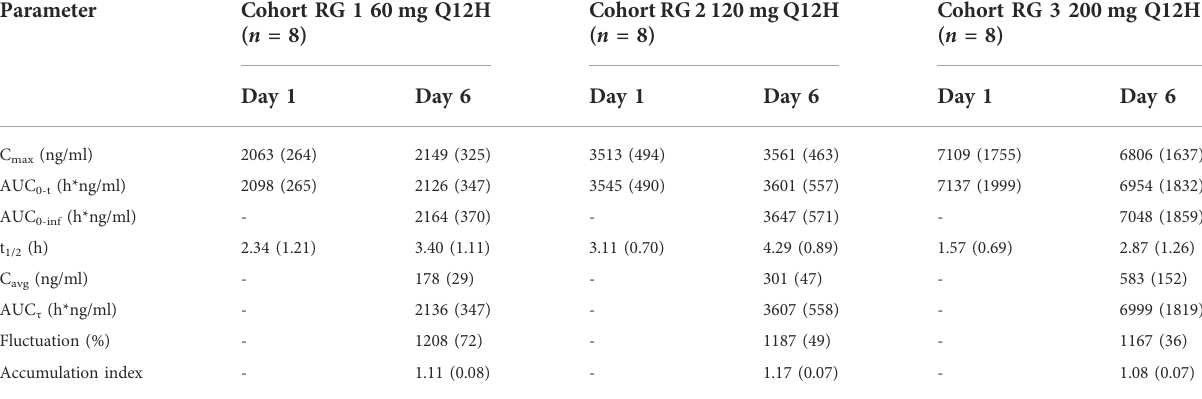
TABLE 3 Pharmacokinetic parameters in the multiple ascending dose